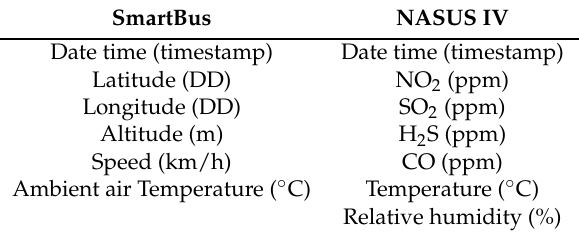
Table 5. Main parameters measured by the SmartBus and NASUS IV. DD: Decimal